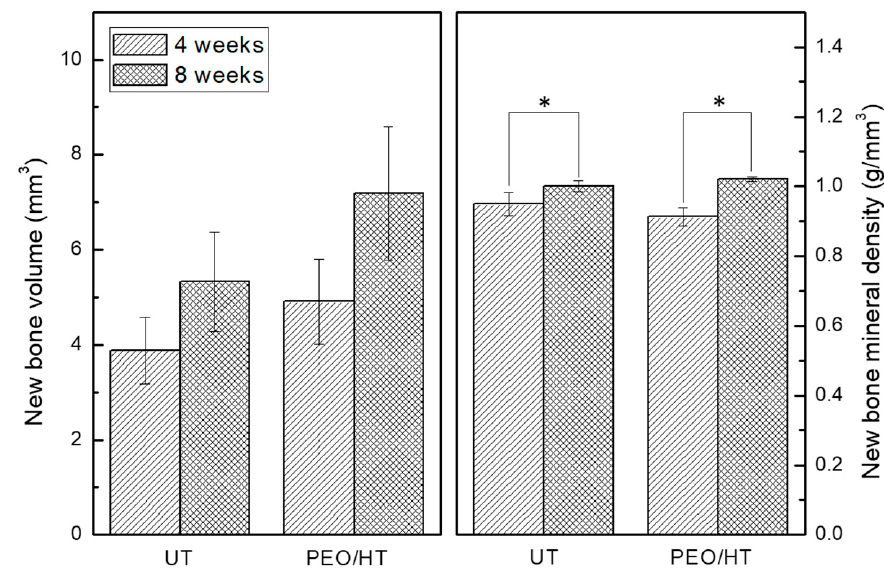
Figure 6. Quantitative volume and mineral density for the new bone formed in rat calvarial defects calculated from the Micro-CT data (* means p < 0.05).